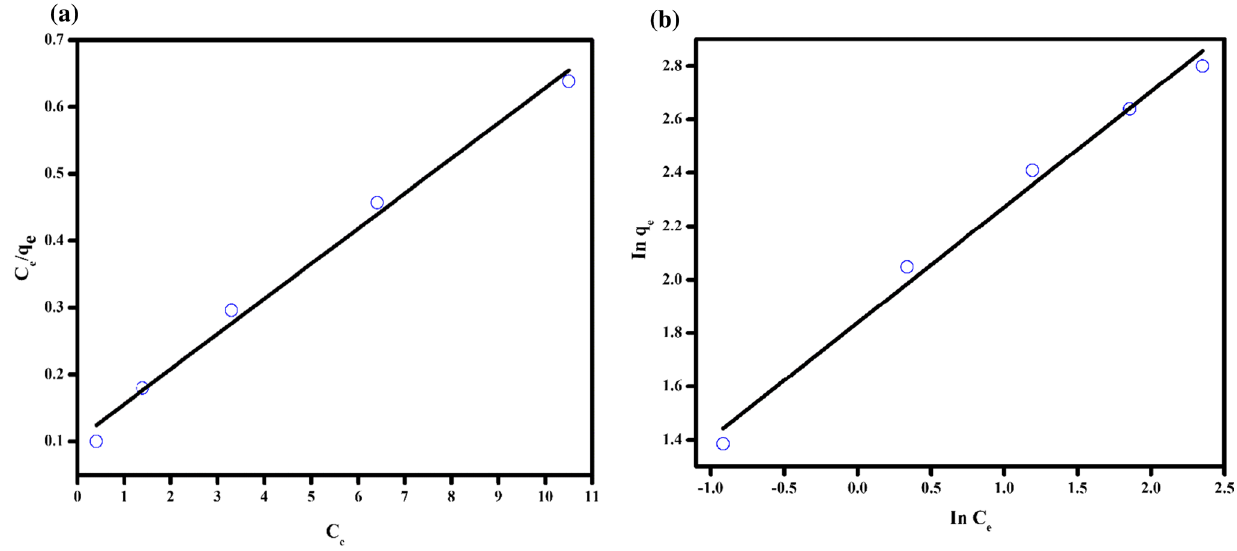
Fig. 10 Isotherm model plots for the adsorption of MB a Langmuir isotherm b Freundlich